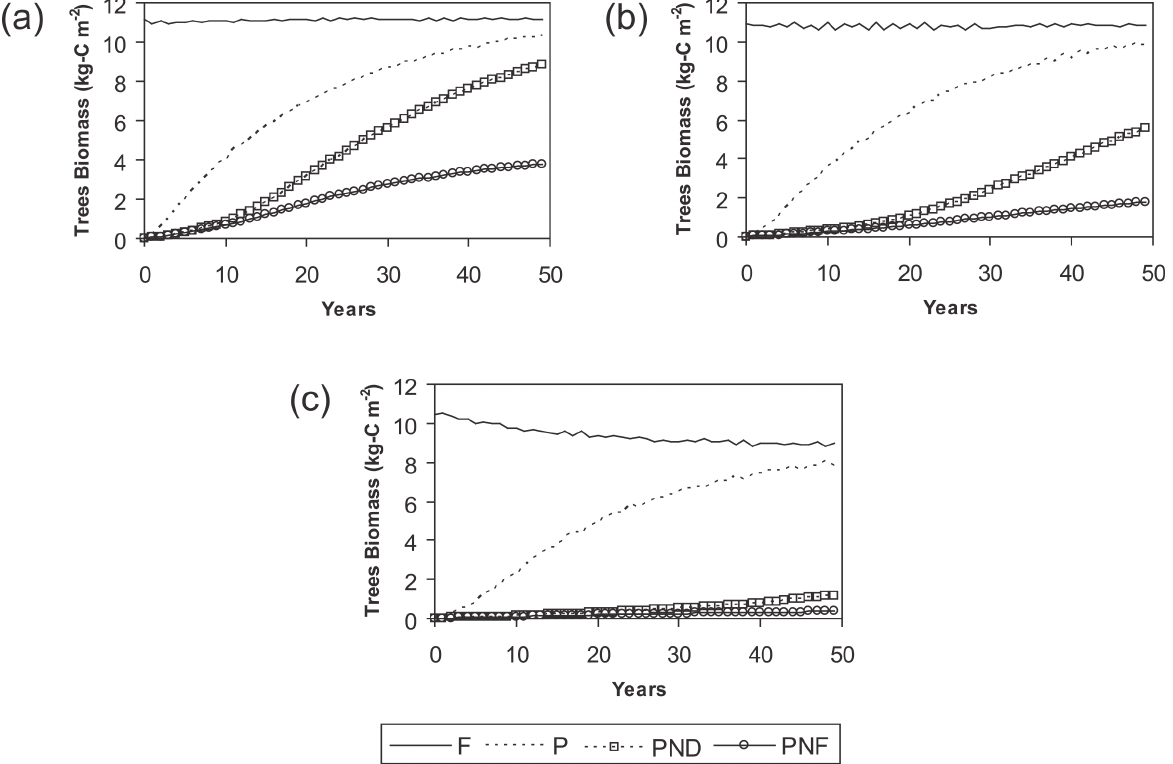
Fig. 4 - The simulated annual mean trees biomass for (a) region 1 - Colombia and northwestern state of Amazonas, (b) region 2 - central Amazonia above 10° S, and (c) region 3 - northern state of Mato